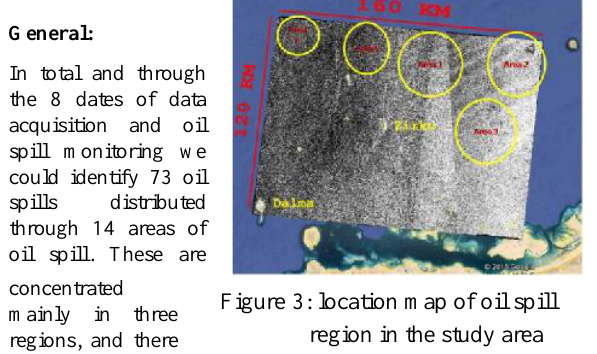
Figure 5: reprojection of AIS